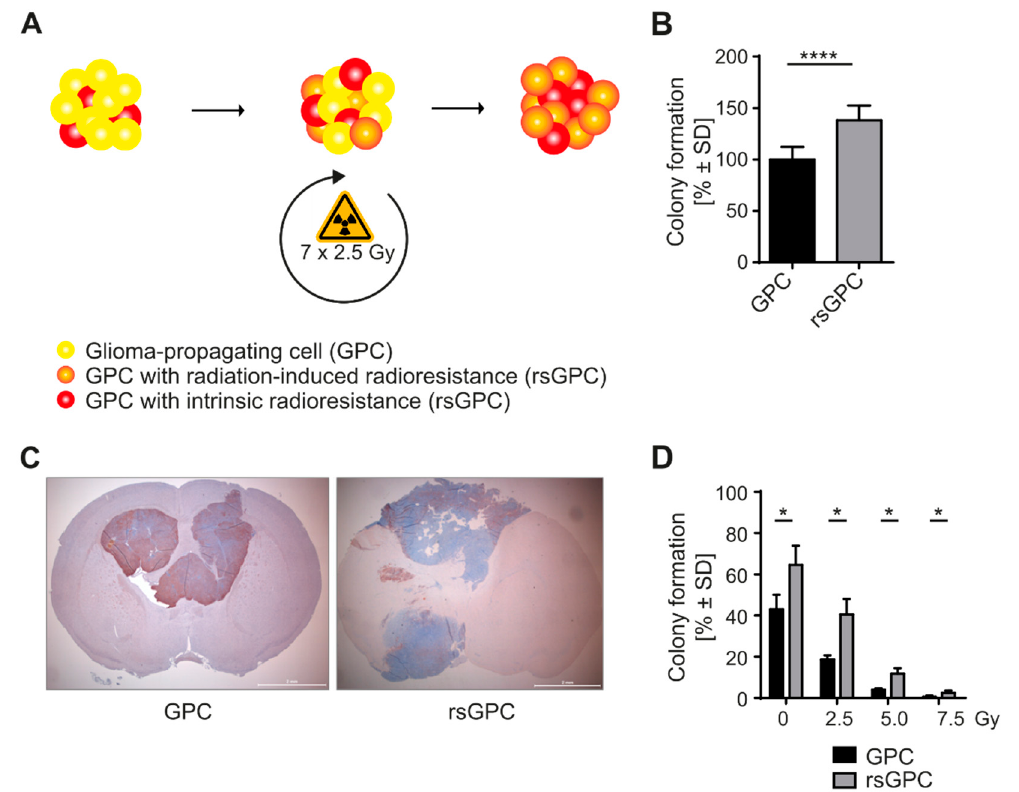
Figure 1. Generation of rsGPCs and challenge towards γ radiation. ( A ) Tumor tissue of GBM patients was dissected and single cells cultured in medium under neural stem cell conditions. GPC spheroids were separated and irradiated with 2.5 Gy (1 Gy/min) in 7 consecutive passages to select for a phenotype with intrinsic or acquired radio-resistance (radio-selected GPCs, rsGPCs). ( B ) rsGPCs and control GPCs were tested for colony formation capacities. The 500 cells/well were plated into a 24-well plate. On culture day 14, the cells were fixed with 2% formalin and counted under a light microscope. rsGPCs showed significantly enhanced colony formation capacities as compared to control GPCs. The results are the mean ± SD of three independent experiments with 4 replicates. The mean number of control GPC colonies was set to 100% and the data normalized to that mean. **** p < 0.0001. ( C ) Xenografts derived from GPCs or rsGPCs. Immunohistochemical staining for nestin. ( D ) rsGPCs and control GPCs were challenged to increasing doses of γ radiation as indicated and colony formation assay was performed. rsGPCs showed significantly enhanced colony formation capacities in contrast control GPCs at 2.5, 5.0, and 7.5 Gy of γ radiation. The means of both untreated control GPCs and rsGPCs were set to 100% and the treatment groups normalized accordingly. * p < 0.05; **** p <